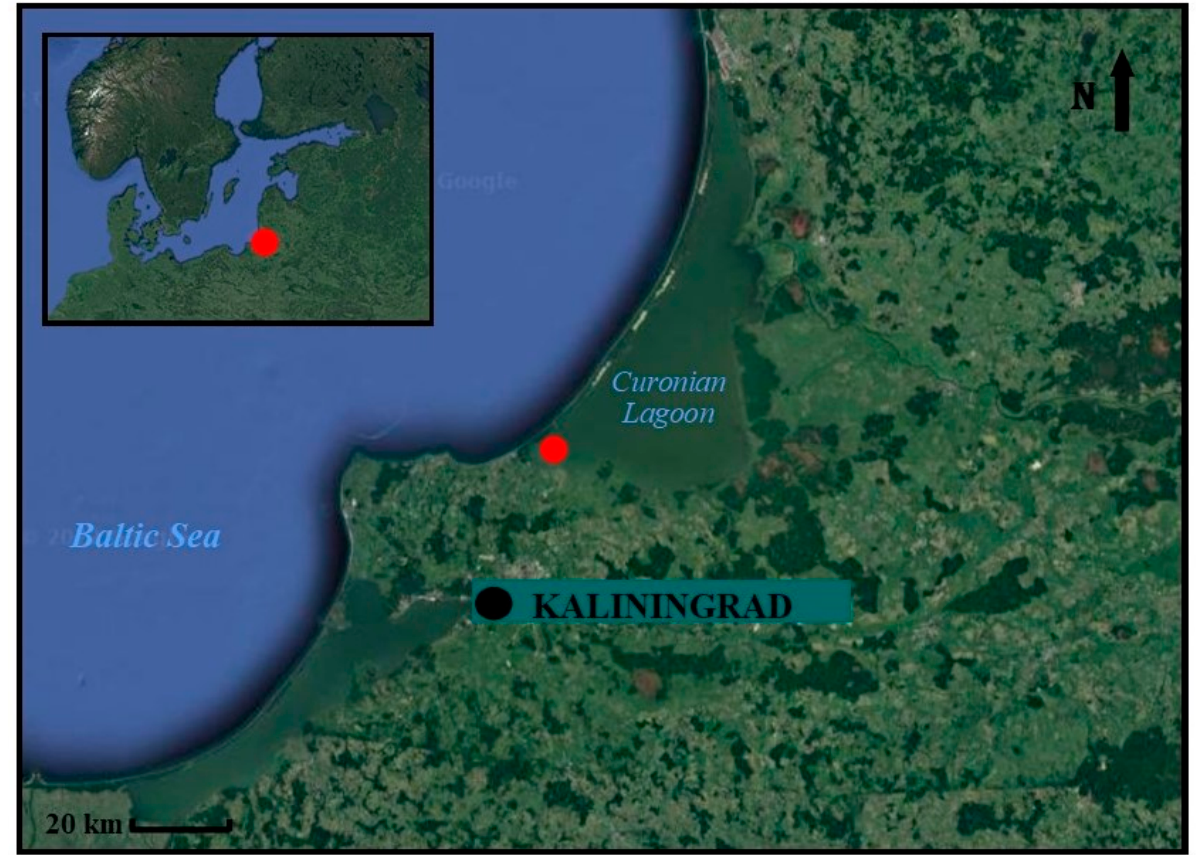
Figure 1. Location of the studied site.